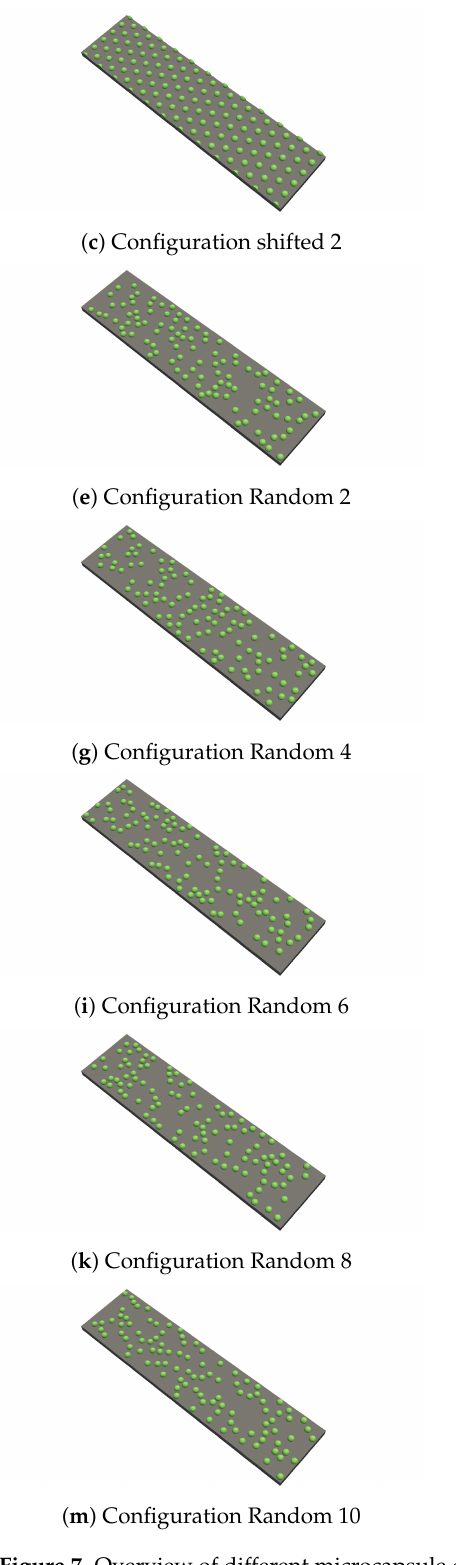
Figure 7. Overview of different microcapsule